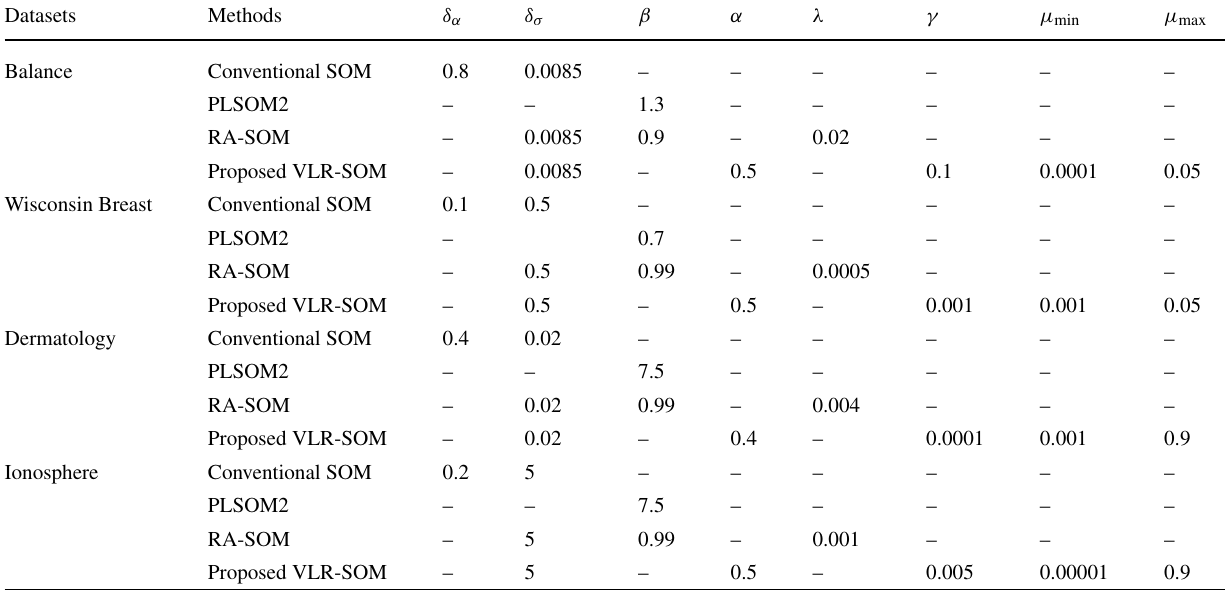
Table 10 Optimal parameters obtained for conventional SOM, PLSOM2, RA-SOM and proposed RZA-SOM algorithms on four UCI benchmark datasets Datasets